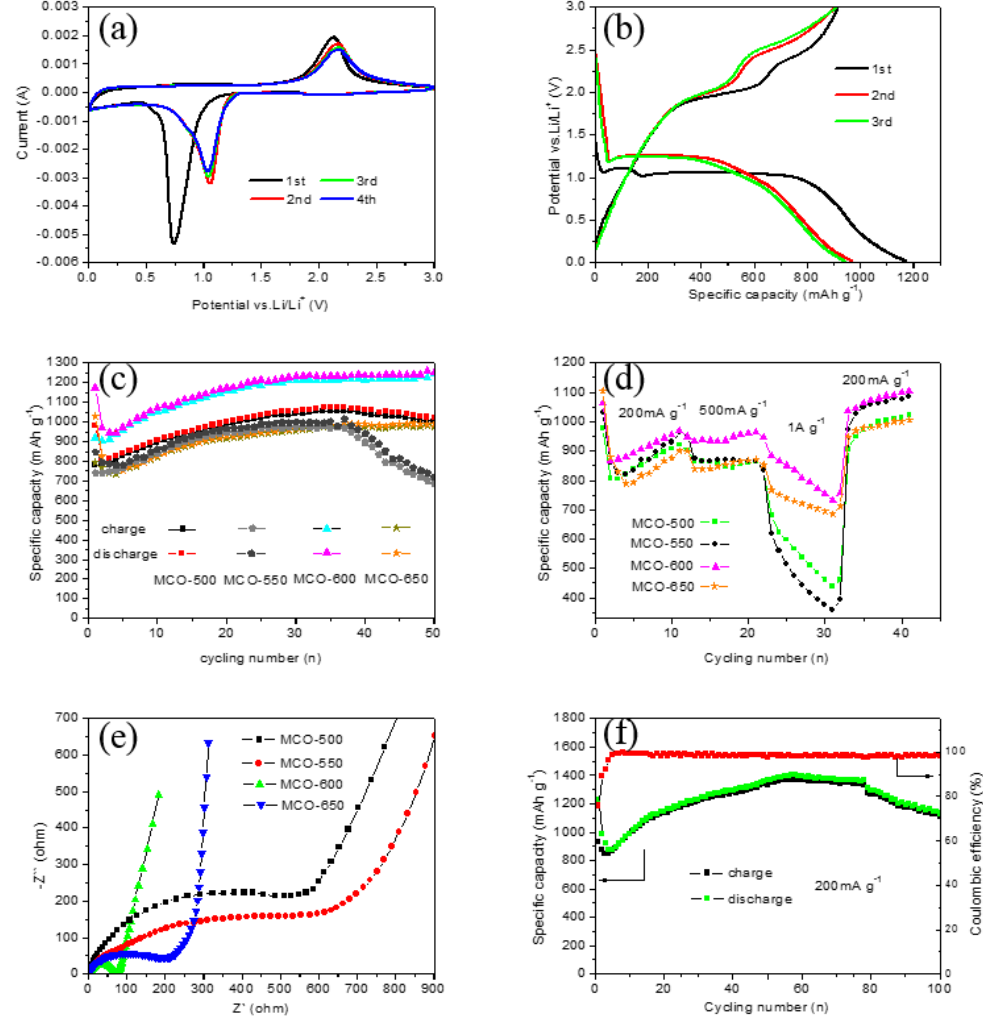
Figure 4. The electrochemical performances of MgCo 2 O 4 : ( a ) the initial four CV cycling curves of as-prepared MCO-600 at 0.5 mV/s ranging from 0.01 V to 3.0 V; ( b ) the initial three galvanostatic charge-discharge curves of MCO-600 at 200 mA g − 1 ; ( c ) cycling performances of MgCo 2 O 4 prepared at various temperatures; ( d ) rate capability of MgCo 2 O 4 prepared at various temperatures; ( e ) the Nyquist plots of MgCo 2 O 4 prepared at various temperatures; ( f ) long cycling performances of MCO-600 at 200 mA g − 1 ranging from 0.01 V to 3.0 V.